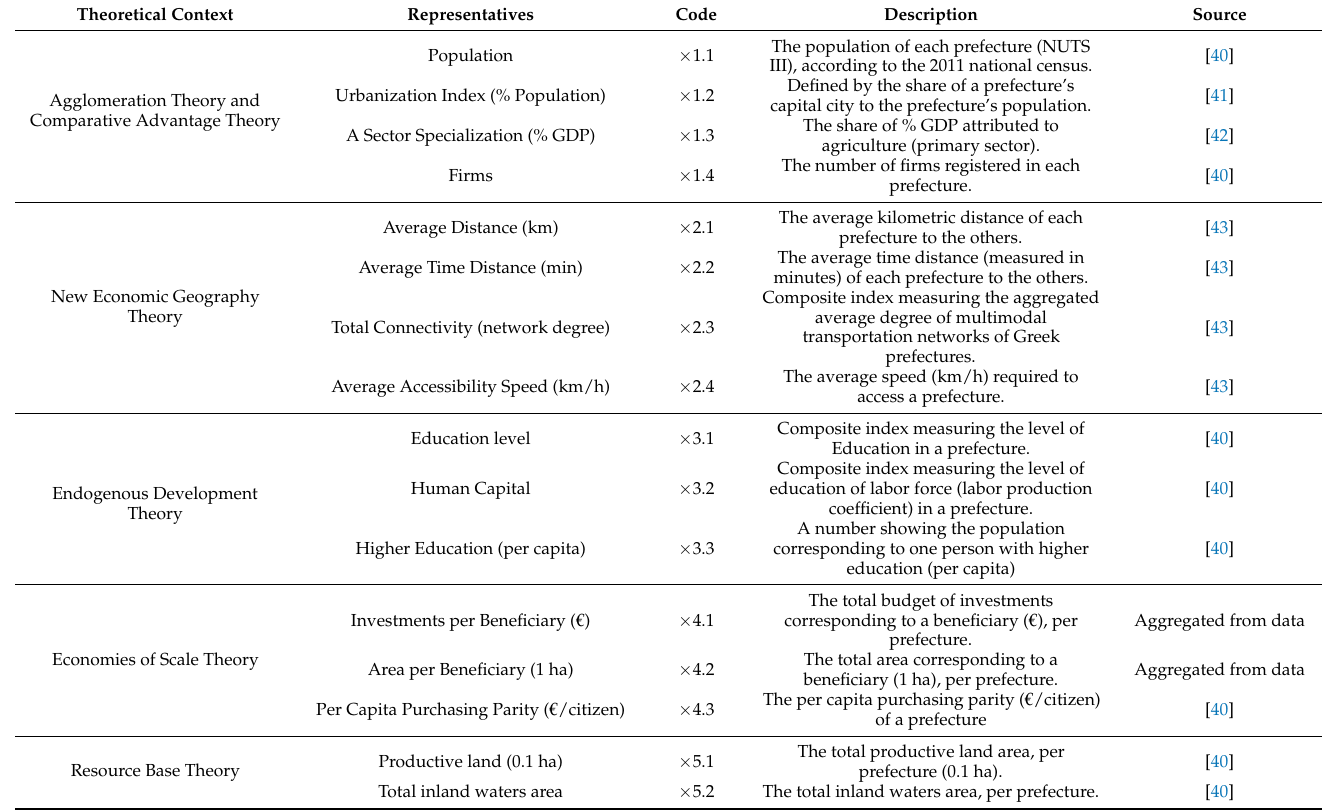
Table 2. The available variables participating in the analysis, grouped in accordance with their thematic